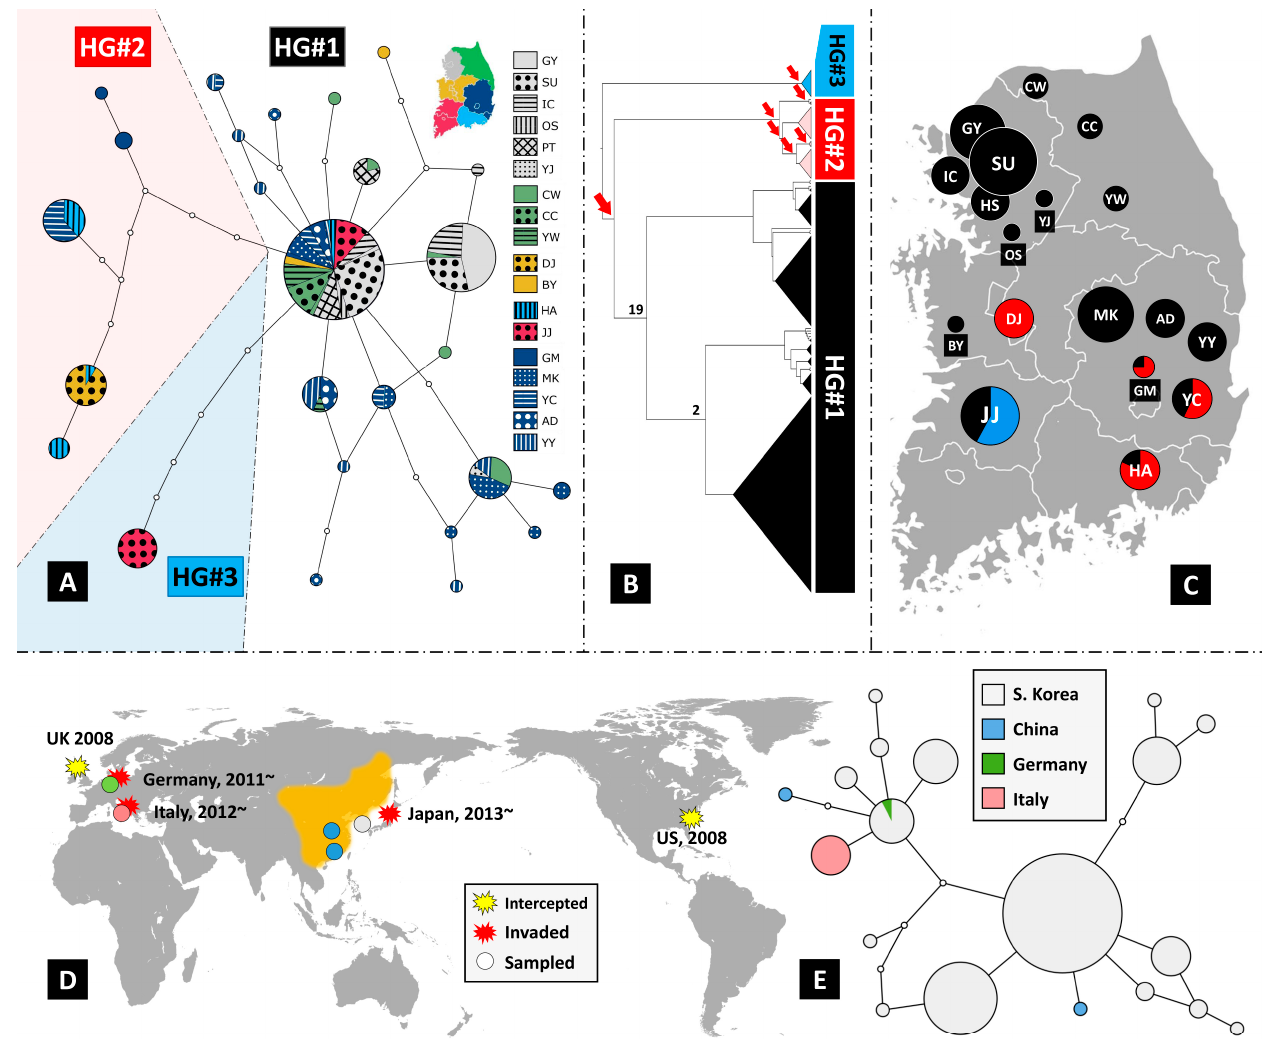
Figure 1. ( A ) Genetic relationships using K-dataset. K-dataset was divided into three haplogroups indicated as HG1~3; ( B ) Phylogenetic relationship using K-dataset. High Ultrafast bootstrap support values (>90) are marked with red arrows. Numbers in two nodes indicate Ultrafast bootstrap values. Colors of the haplogroups in pie chart correspond to Figure 1A; ( C ) Haplogroup distribution of K-dataset and their genetic clusters inferred from COI data. Colors of the haplogroups in pie chart correspond to Figure 1A; ( D ) Orange mark: global distribution of RLB. Circles: sampled sites of G-dataset. Red explosion icon: invaded areas. Yellow explosion icon: intercepted areas. ( E ) Genetic relationships using K-dataset. Labels of collection sites are indicated in the upper right boxes.